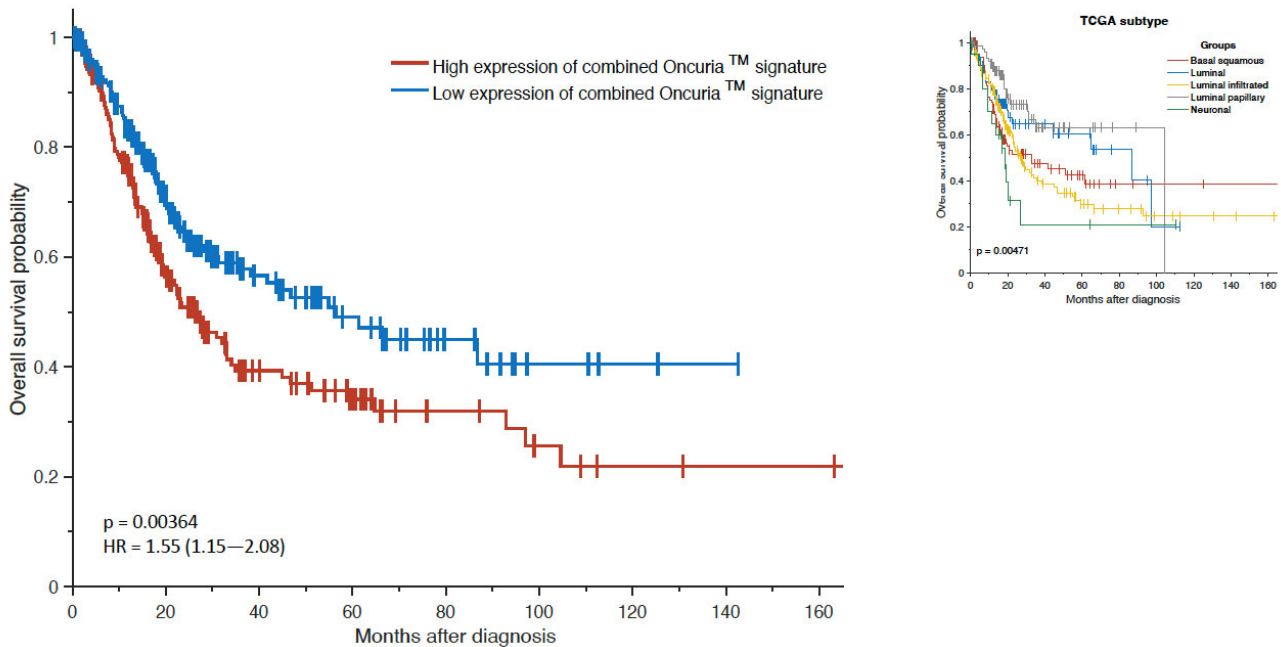
Figure 2. Kaplan–Meier survival curves for high vs. low expression of the combined Oncuria™ signature in TCGA cohort; insert depicts TCGA analyzed by the consensus model.